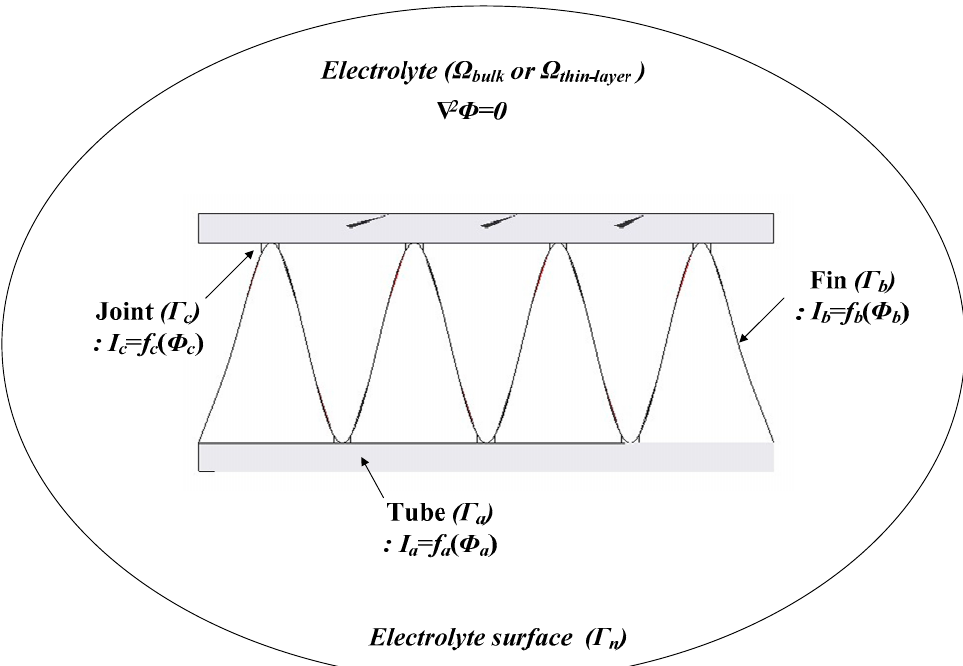
Figure 2. Boundary conditions for corrosion simulation of the Al fin-tube heat exchanger.